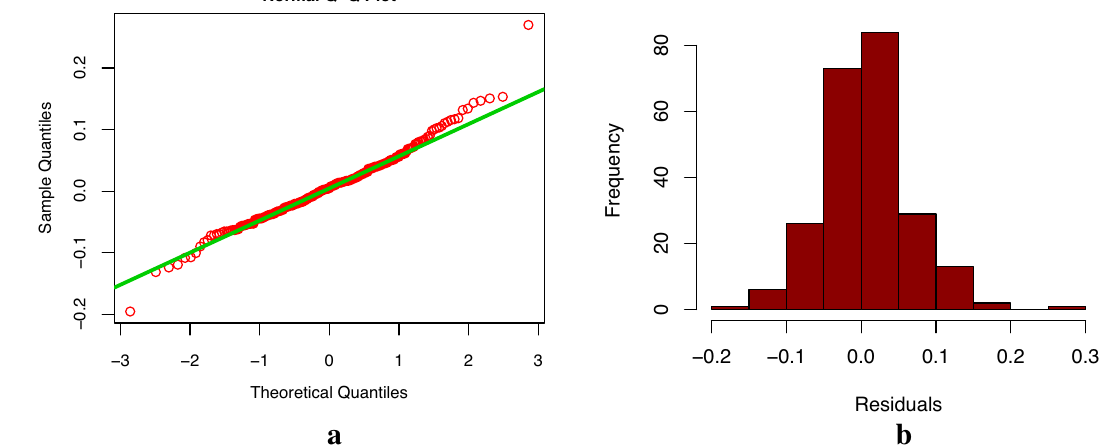
Figure 8. Normal distribution Q-Q graph ( a ) and histogram ( b ) of Holt-Winters’ multiplicative model residuals.